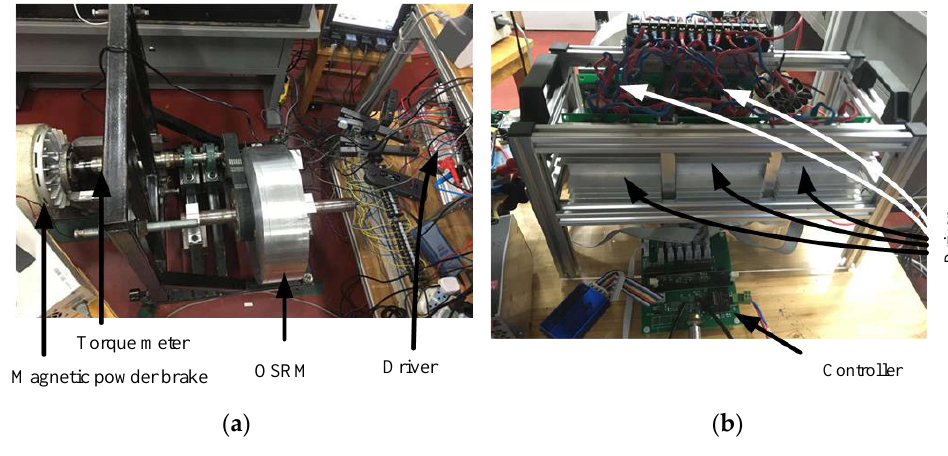
Figure 10. Five-phase 20/16 pole OSRM structure block diagram of the speed regulation system.